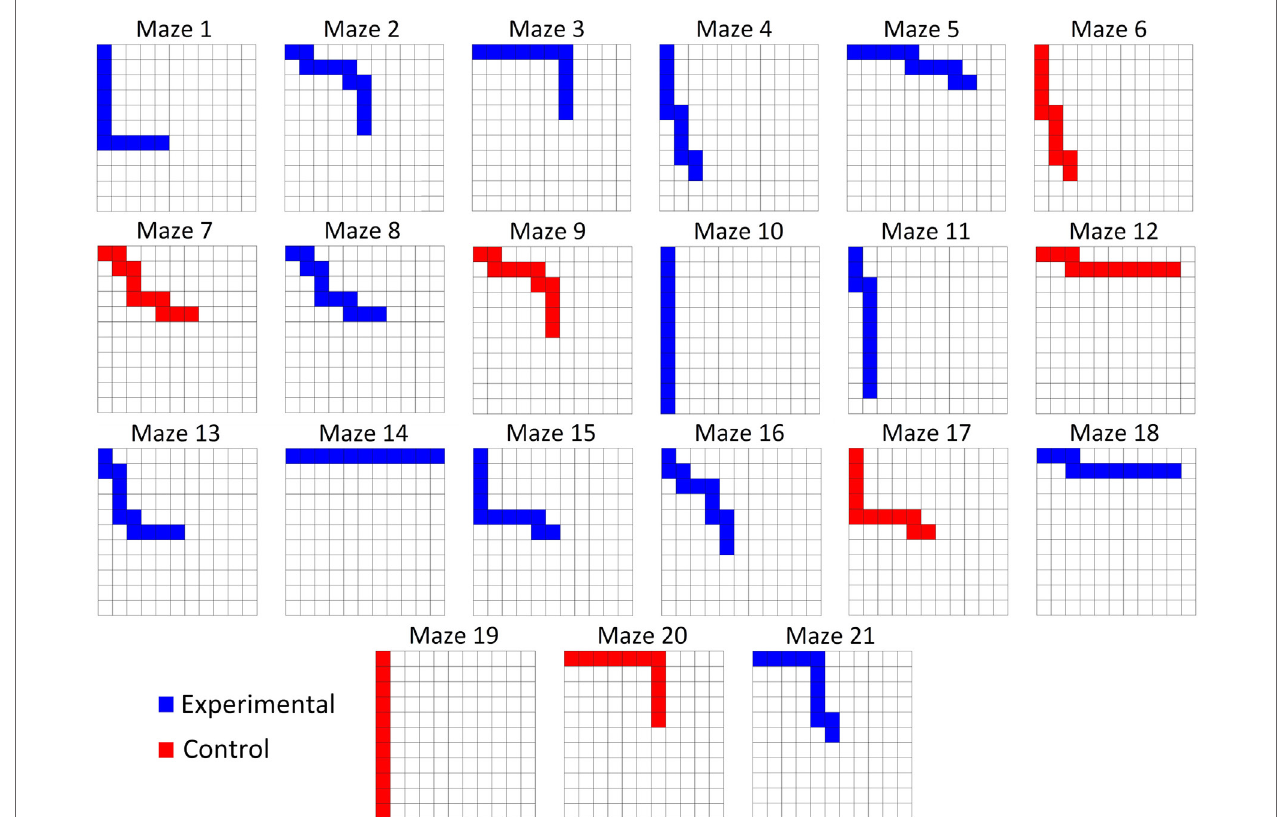
FigUre 2 | all subjects were tested on the same mazes in the same order . Each maze was 10 steps in length. Participants only advanced if they correctly interpreted the input from the CBI and made the correct